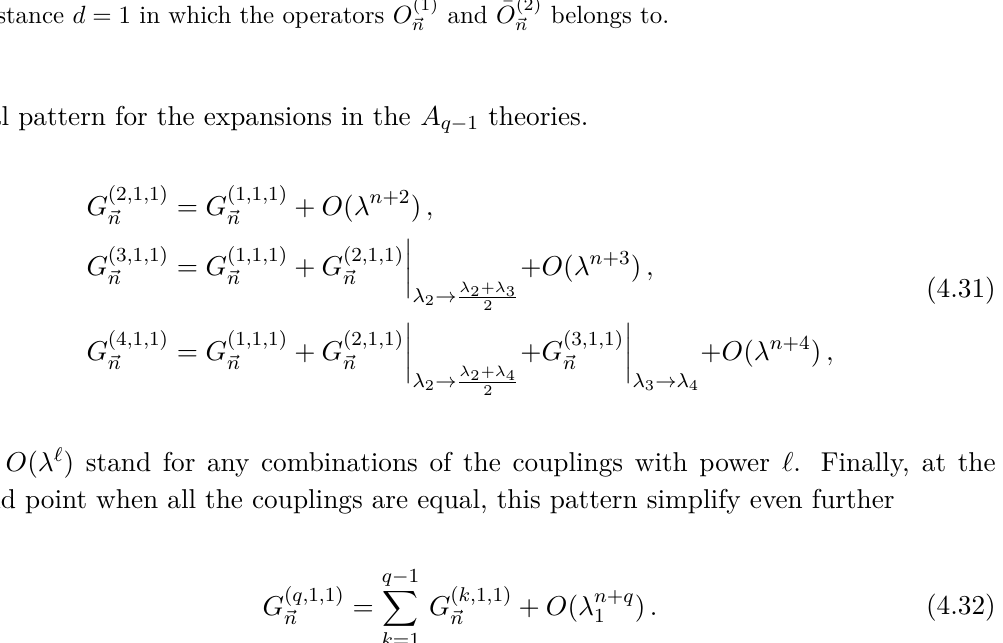
and ¯ O (2) belongs to. ~n ~n